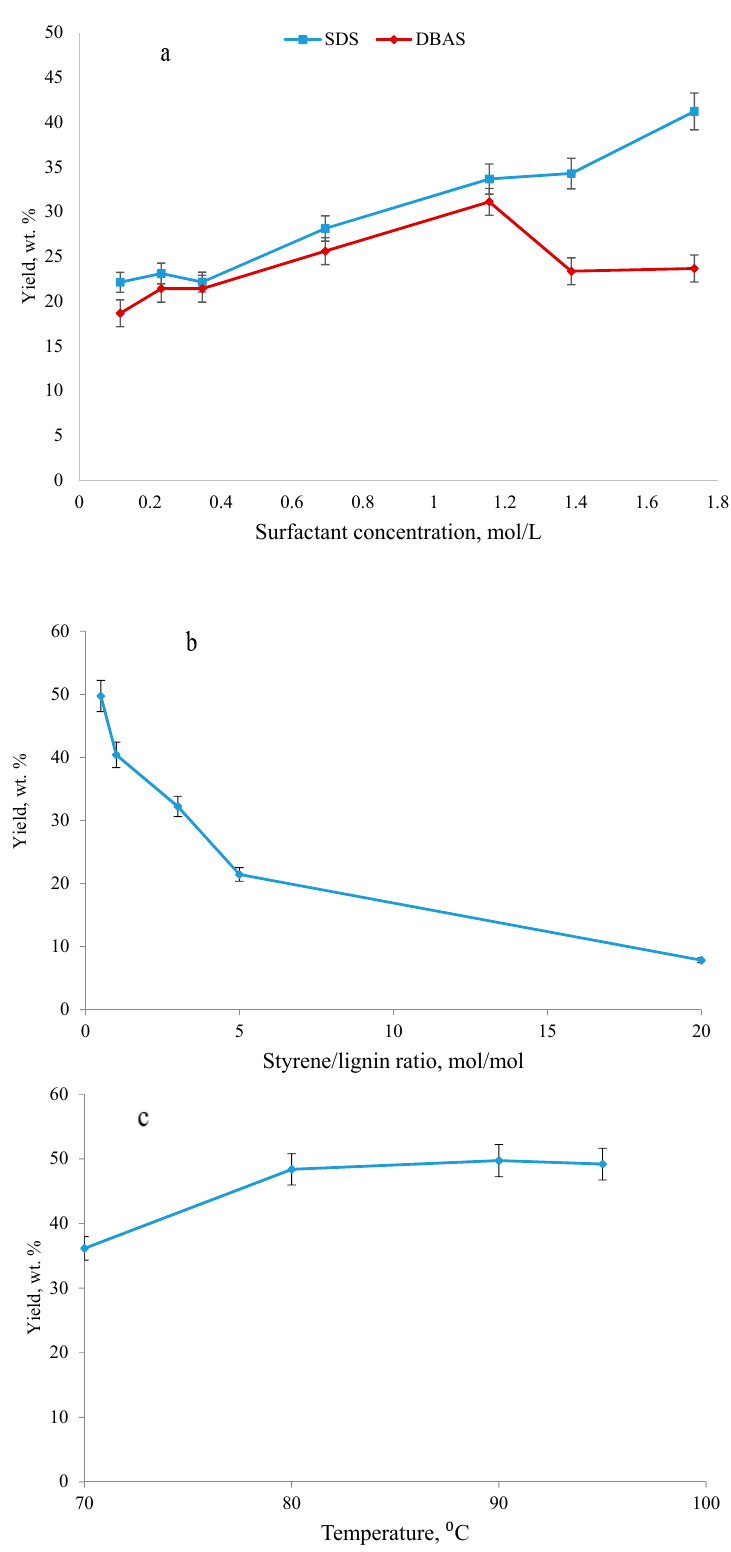
Figure 1. Effect of ( a ) surfactant type and concentration, ( b ) styrene/lignin molar ratio and ( c ) temperature on the yield of polymerization reaction (experiments were performed under the conditions of 100 g/L lignin concentration, pH 1.5 and 2 h). SDS—sodium dodecyl sulfate; DBAS—dodecyl benzenesulfonic acid.